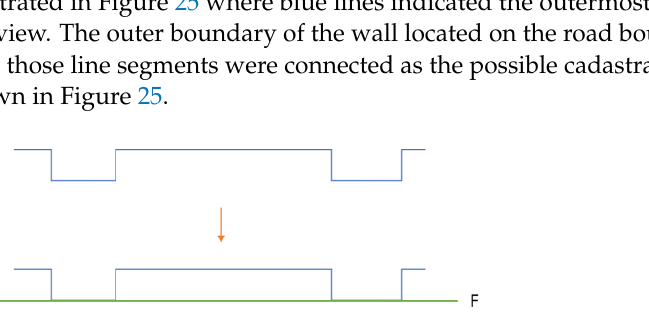
Figure 26. The result of digitized detail lines from the corrected handheld LiDAR point cloud. 3.3.5. Results Analysis (1) Analysis of detail line data The digitized data of the corrected hand-held LiDAR point cloud and the results sur- vey by a total station are shown in Figure 27. The orange points were the detail points surveyed by a total station. By visual inspection, there was no significant difference be- tween the digitized detail lines and detail points.